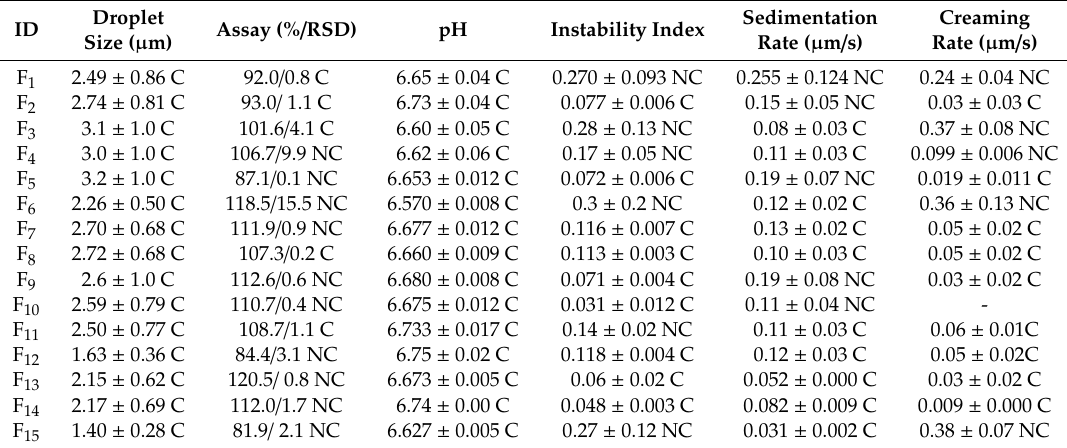
Table 5. E ff ect of independent variables on di ff erent cream